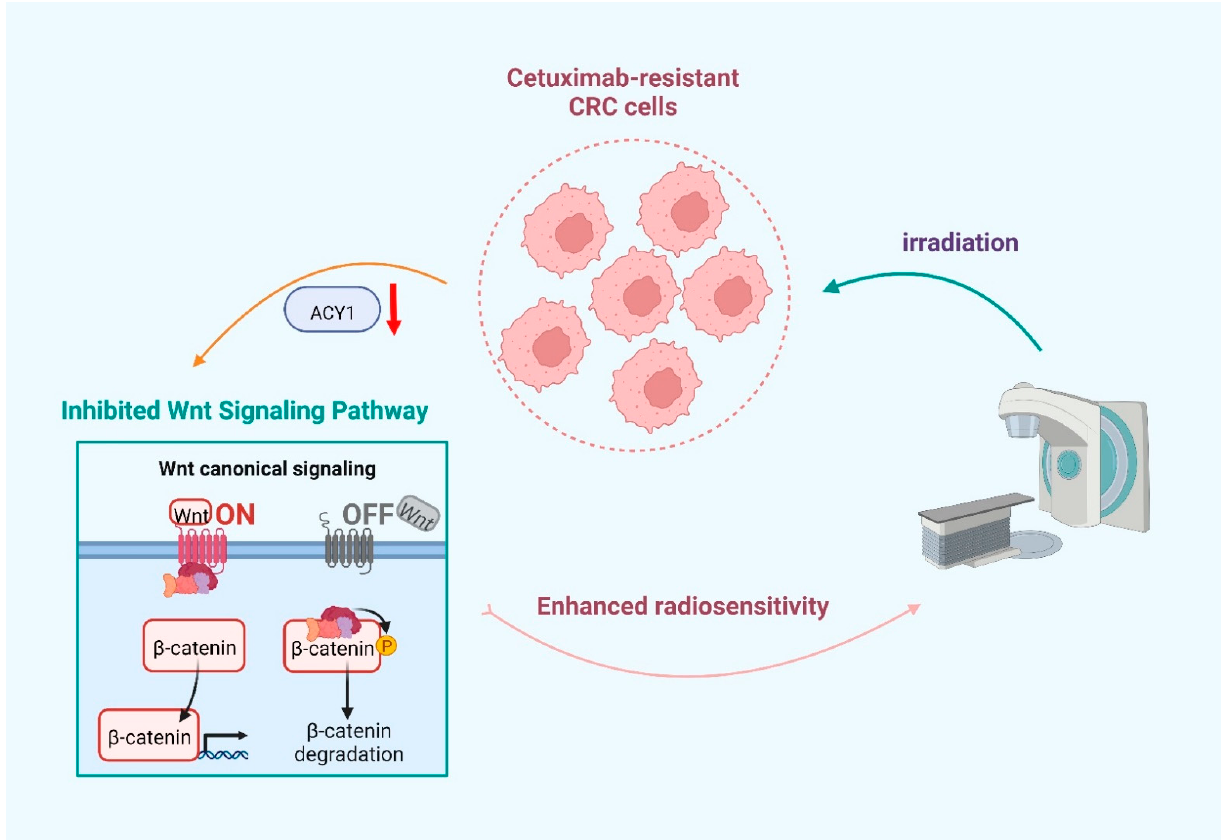
Figure 8. Schematic of ACY1 downregulation enhances the radiosensitivity of cetuximab-resistant colorectal cancer by inactivating the Wnt/ β‐ catenin signaling pathway.